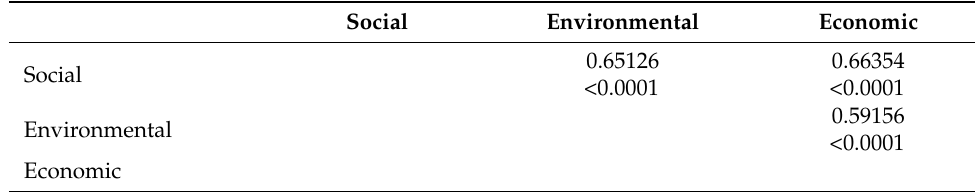
Table 7. Standardized Covariance